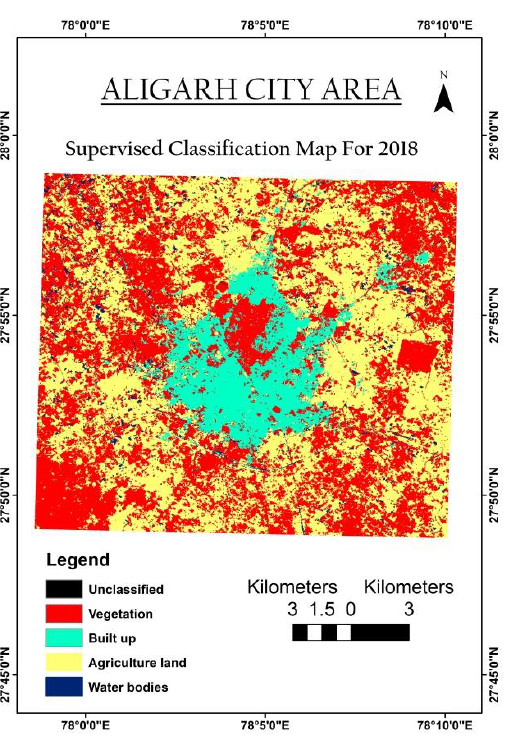
Fig 5 . Expanded urban sprawl mapped for